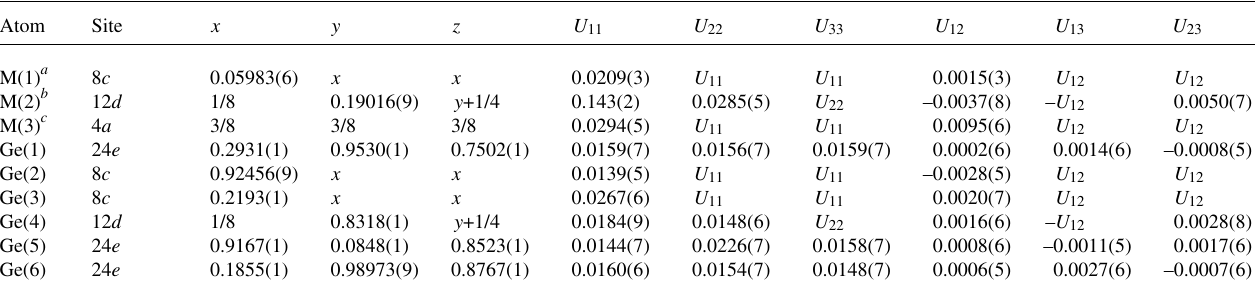
Table 3. Atomic coordinates and displacement parameters (in Å 2 ) .